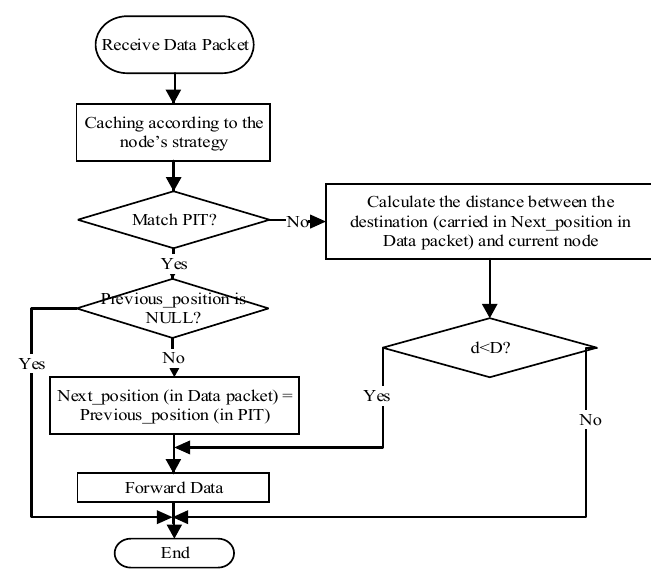
Figure 10. Forwarding control of Data packet.